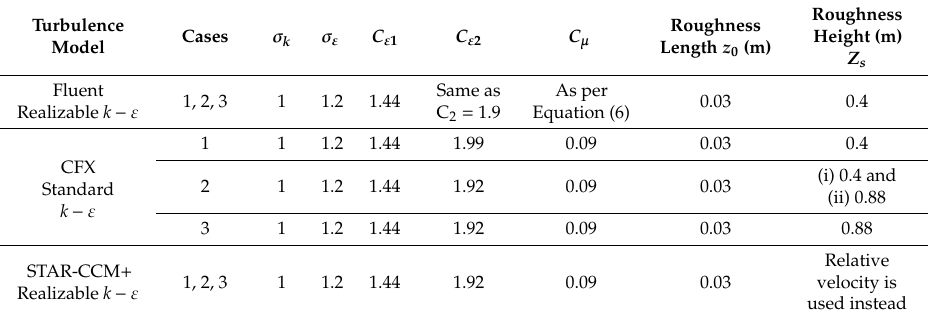
Table 1. Model Parameters in the Three Software.